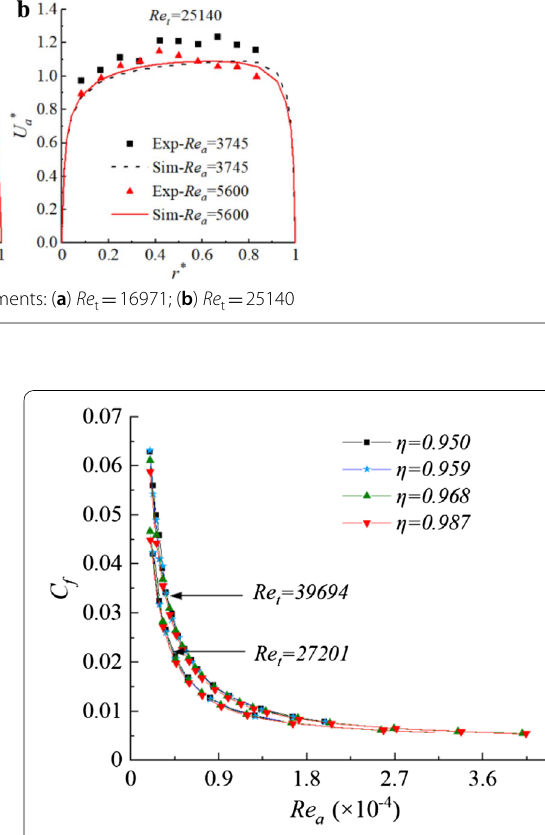
Figure 9 Results of the frictional coefficients with different radius